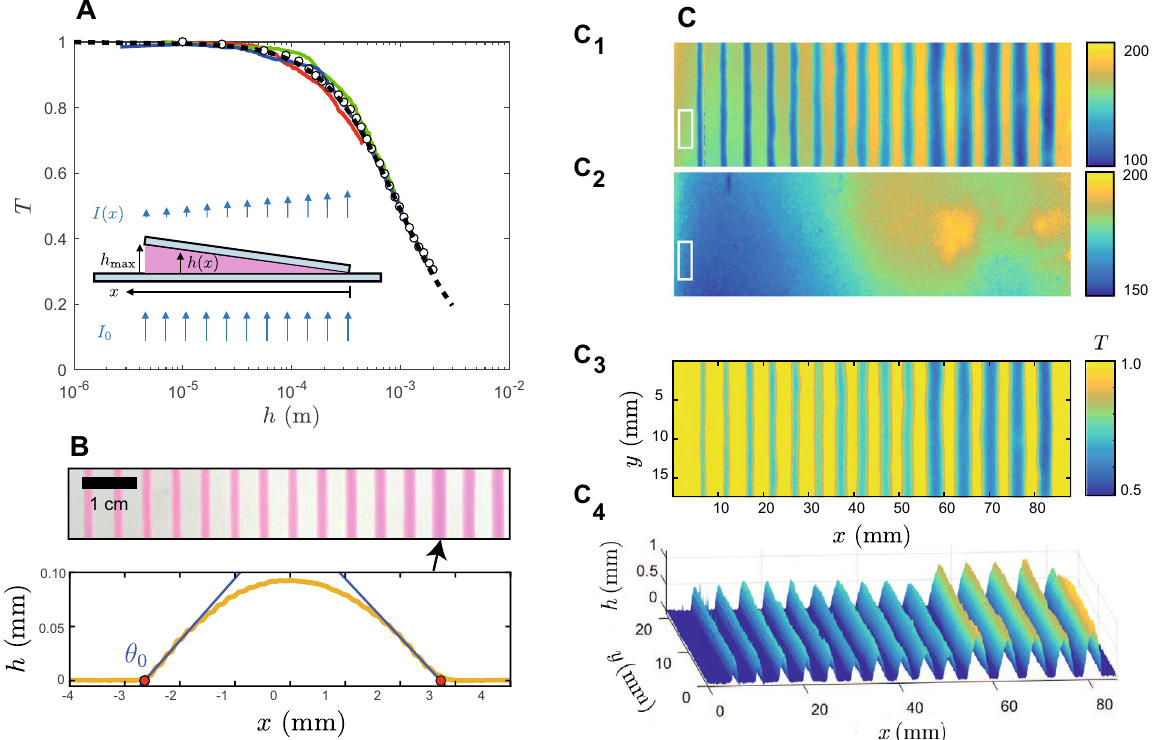
Figure 7. Colorimetric calibration. ( A ) Transmission of a dyed gel measured against thickness in a wedge geometry where h max is known. The coloured lines correspond to several h max , the open symbol show the average of these data, and the black dashed line an empirical fit F ( h ) . ( B ) Linear deposits are obtained for several Q / v and the height profiles are measured using F ; an example of profile is shown, from which the deposited area A and the contact θ 0 angle can be measured. ( C ) Converting an image (C1) into a topographic measurement (C4) through the acquisition of a reference (C2), giving the transmission T (C3) and the height profiles